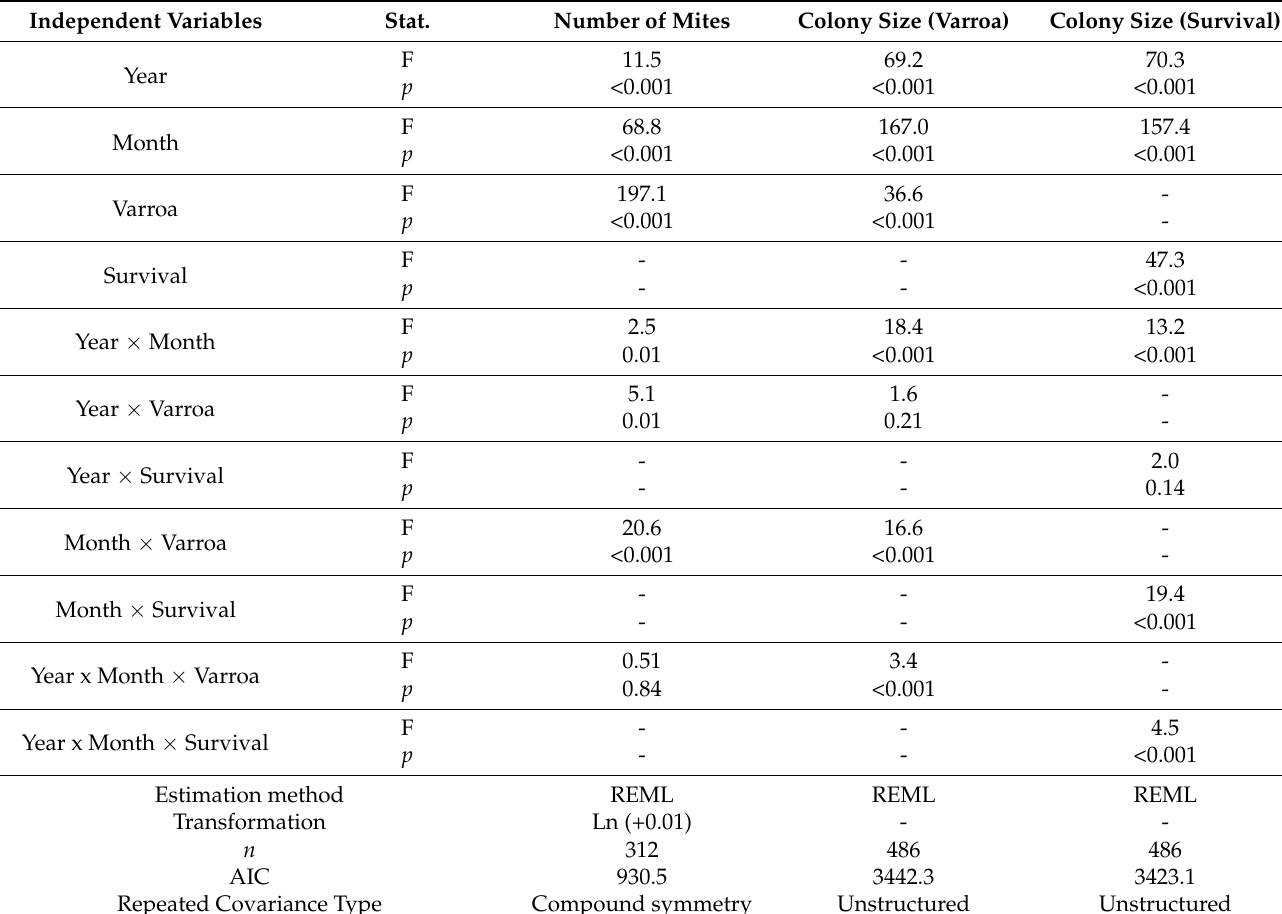
Table 2. Results of the linear mixed models for the effects of Varroa destructor (Varroa). Year and month are shown, including their interaction with the number of mites per gram of bees and the colony size (% top cover). For each factor in the model, the F- and p -values are given. For each model, we give the applied method of estimation (REML = restricted maximum likelihood), whether we Ln-transformed the dependent variable (Ln), the sample size ( n ), the value of the Aikaike’s information criterion (AIC) and the Repeated Covariance Type.